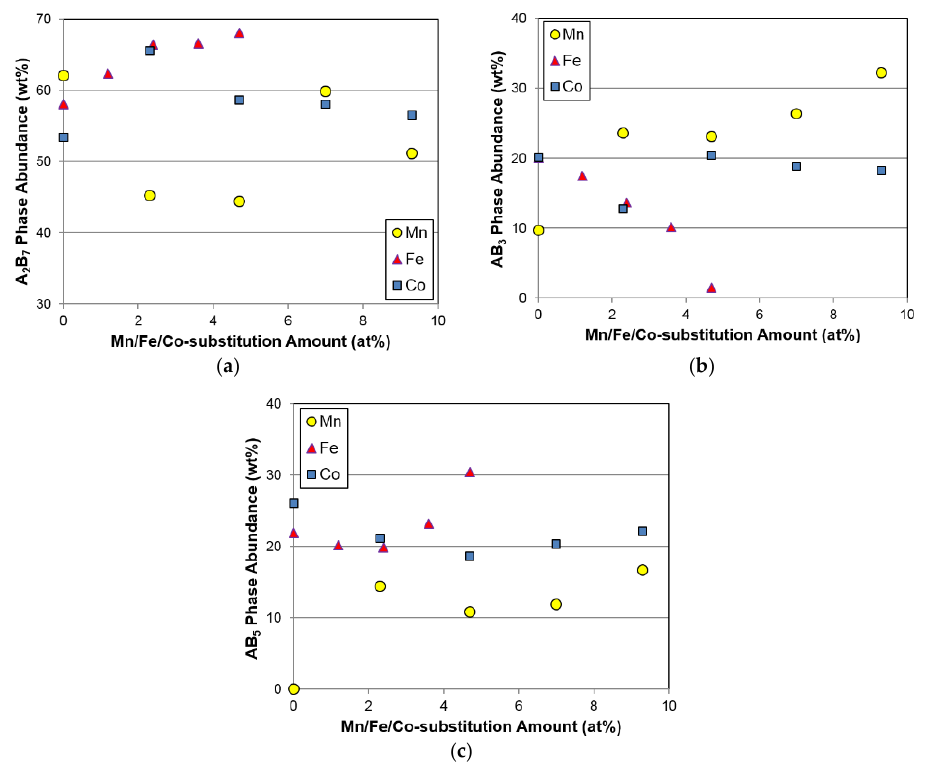
Figure 4. Changes in the ( a ) A 2 B 7 ; ( b ) AB 3 ; and ( c ) AB 5 phase abundances with increasing